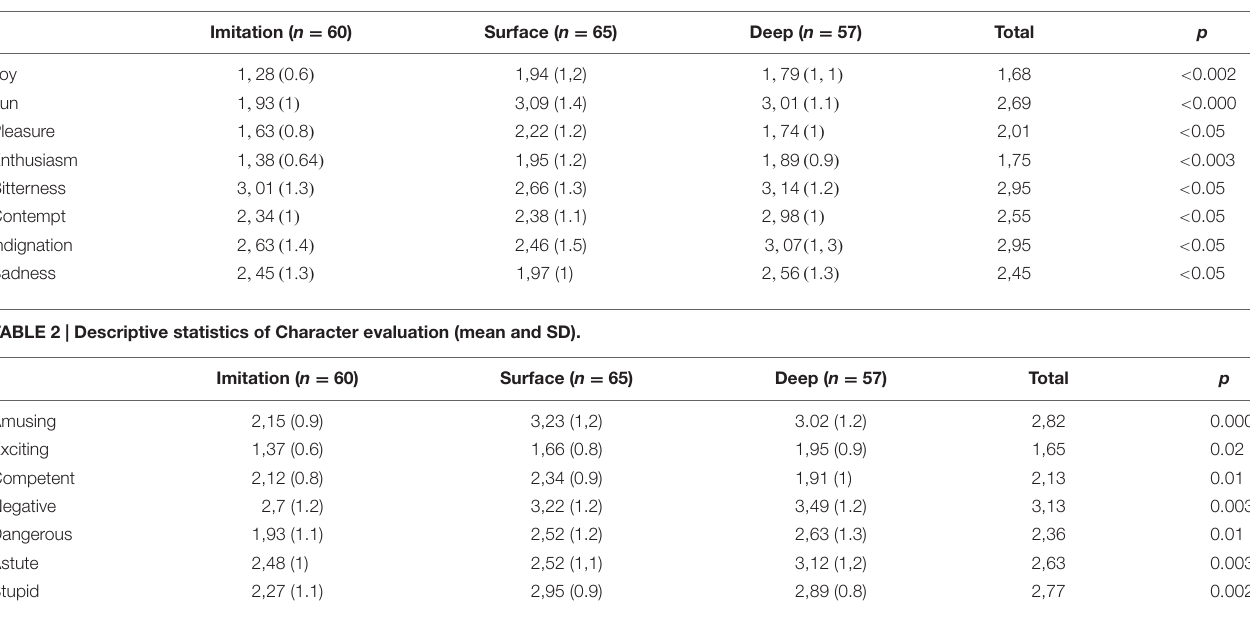
TABLE 1 | Descriptive statistics of emotions (mean and SD).